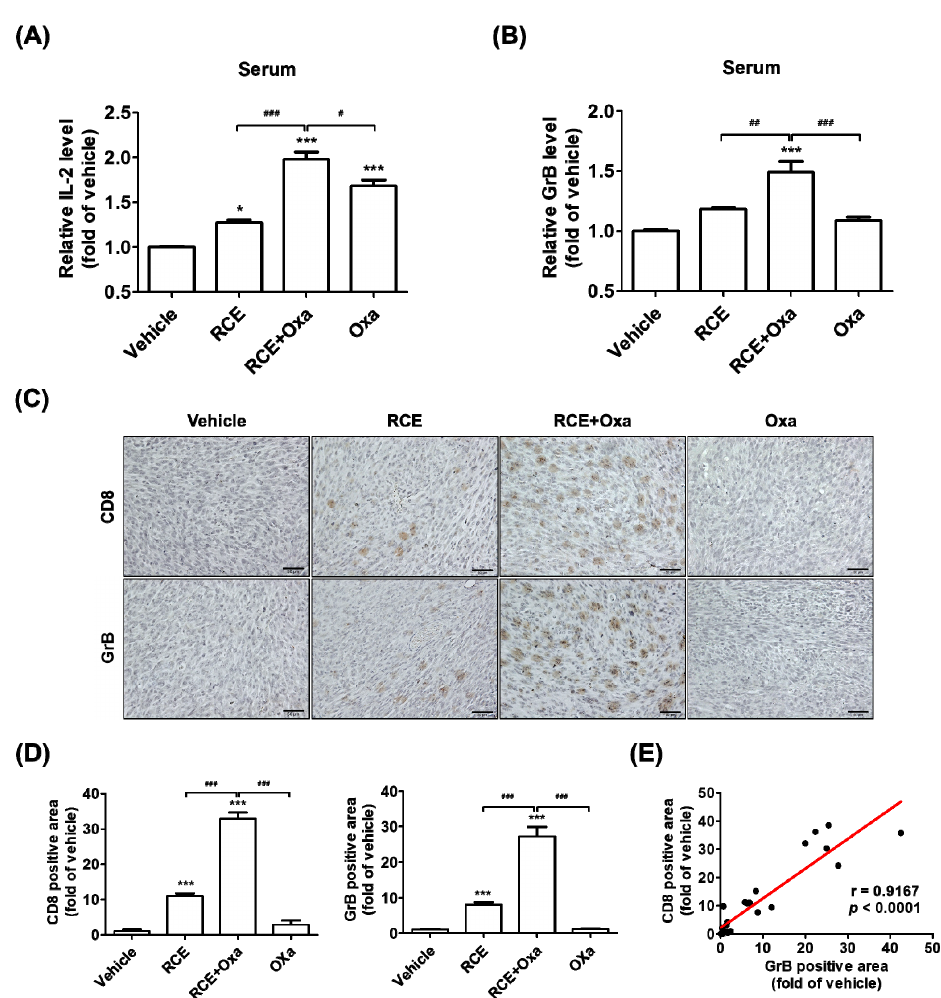
Figure 4. RCE plus Oxa activated tumor-infiltrating CD8 + T cells in the human PD-1/PD-L1 MC38 tumor allograft mouse model. ( A , B ) Relative IL-2 level ( A ) and GrB level ( B ) in human PD-1/PD-L1 MC38 tumor mouse serum. ( C ) Representative images (×400) of hPD-L1 MC38 tumors showing CD8 and GrB staining by immunohistochemical analysis (bar indicates 50 μ m). ( D ) Relative CD8 and GrB positive area of hPD-L1 MC38 tumors calculated using immunohistochemical analysis. ( E ) Expression levels of CD8 and GrB are positively correlated among all hPD-L1 MC38 tumors ( n = 24). * p < 0.05 and *** p < 0.001 compared with the vehicle group, # p < 0.05, ## p < 0.01, and ### p < 0.001 compared to the individual